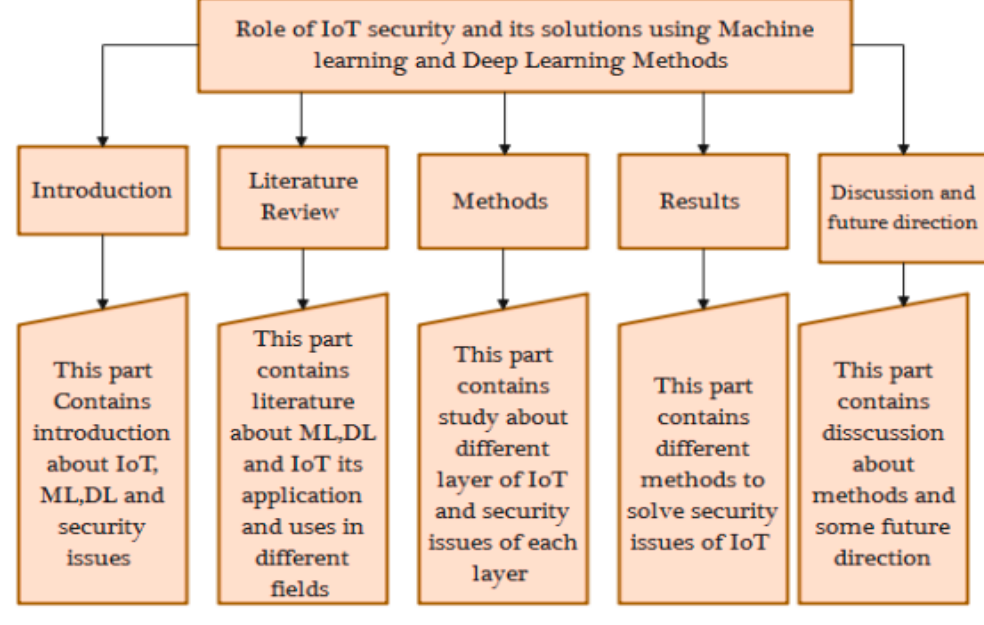
Figure 1. Taxonomy of the study